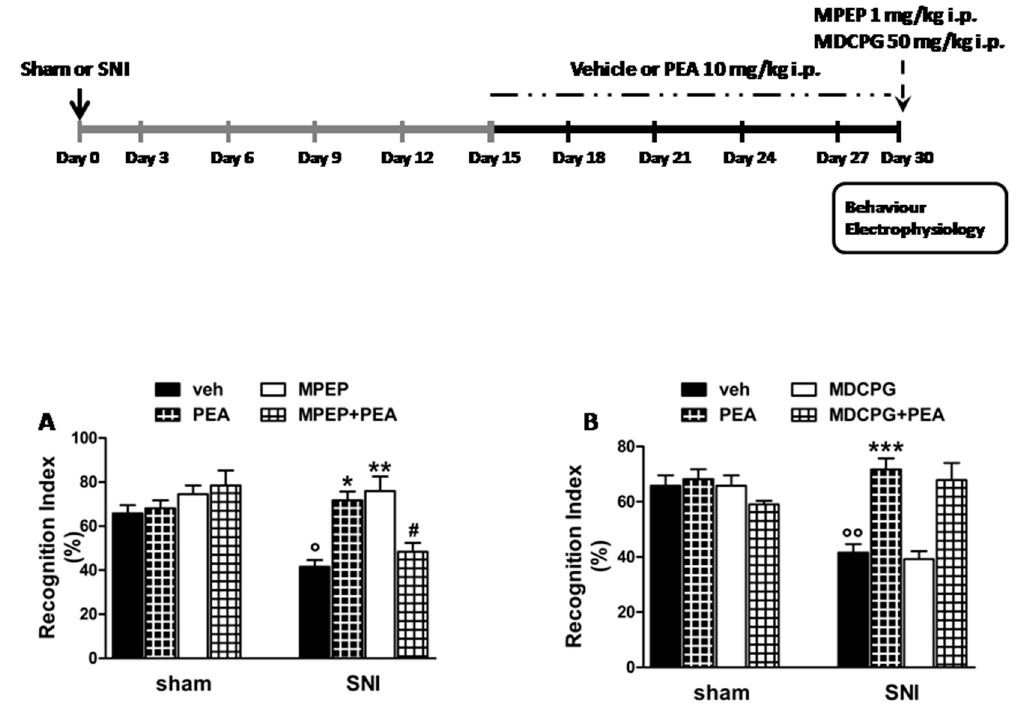
Figure 1. Effect of a single administration of vehicle, MPEP (1 mg/kg, i.p.), MDCPG (50 mg/kg, i.p.) on discriminative memory in sham and SNI mice receiving a 15-day treatment with vehicle or PEA (10 mg/kg, i.p.) 15 day after the sham or SNI surgery (day 0). The upper panel shows the experimental design and timeline of the sham or SNI surgery, the chronic treatment with vehicle or PEA and the single administration of vehicle, MPEP or MDCPG. ( A , B ) show the effect of vehicle, MPEP ( A ) or MDCPG ( B ) on the recognition index (RI) in sham or SNI receiving a chronic treatment with vehicle or PEA (10 mg/kg, i.p.). The administration of vehicle MPEP or MDCPG was carried out 1 h before the acquisition trial. Data are represented as the mean ± SEM of six mice per group. ◦ indicates significant differences vs.sham/veh, * indicates significant differences vs. SNI/veh and # indicates significant differences vs.SNI/PEA in SNI mice. p < 0.05 was considered statistically significant.